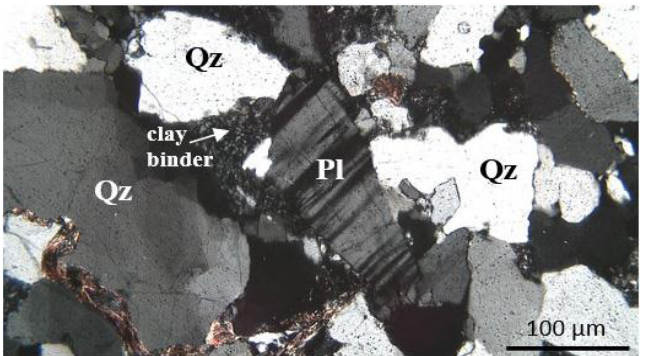
Figure 11. Grains of plagioclase (Pl) and quartz (Q z ) surrounded by clay binder: crossed polars— 100× magnification.